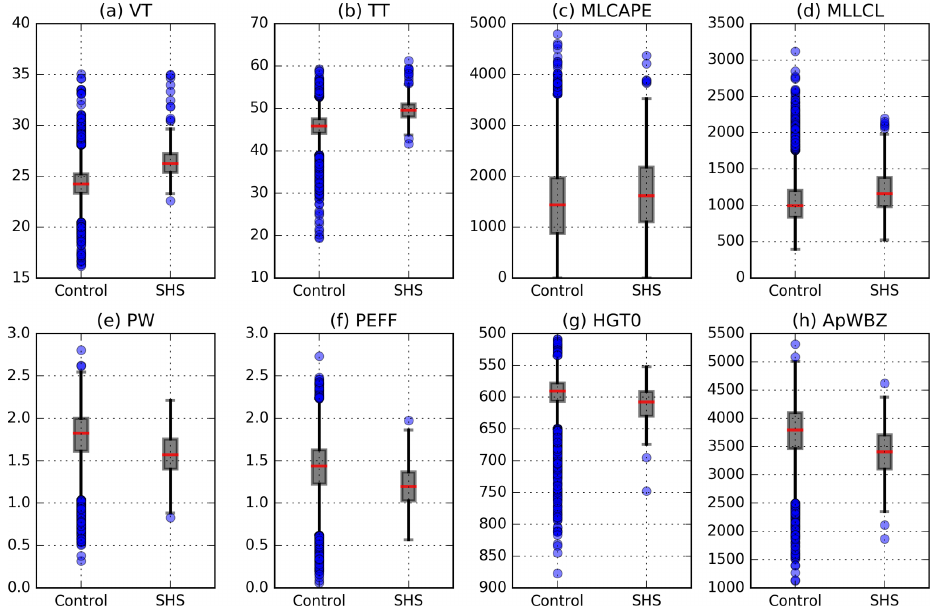
Figure 7. Same as Fig. 5 except for SHS days. Panels (a–d) replicate the same variables shown in Fig. 5, whereas (e–h) are replaced with four SHS-specific parameters from Table